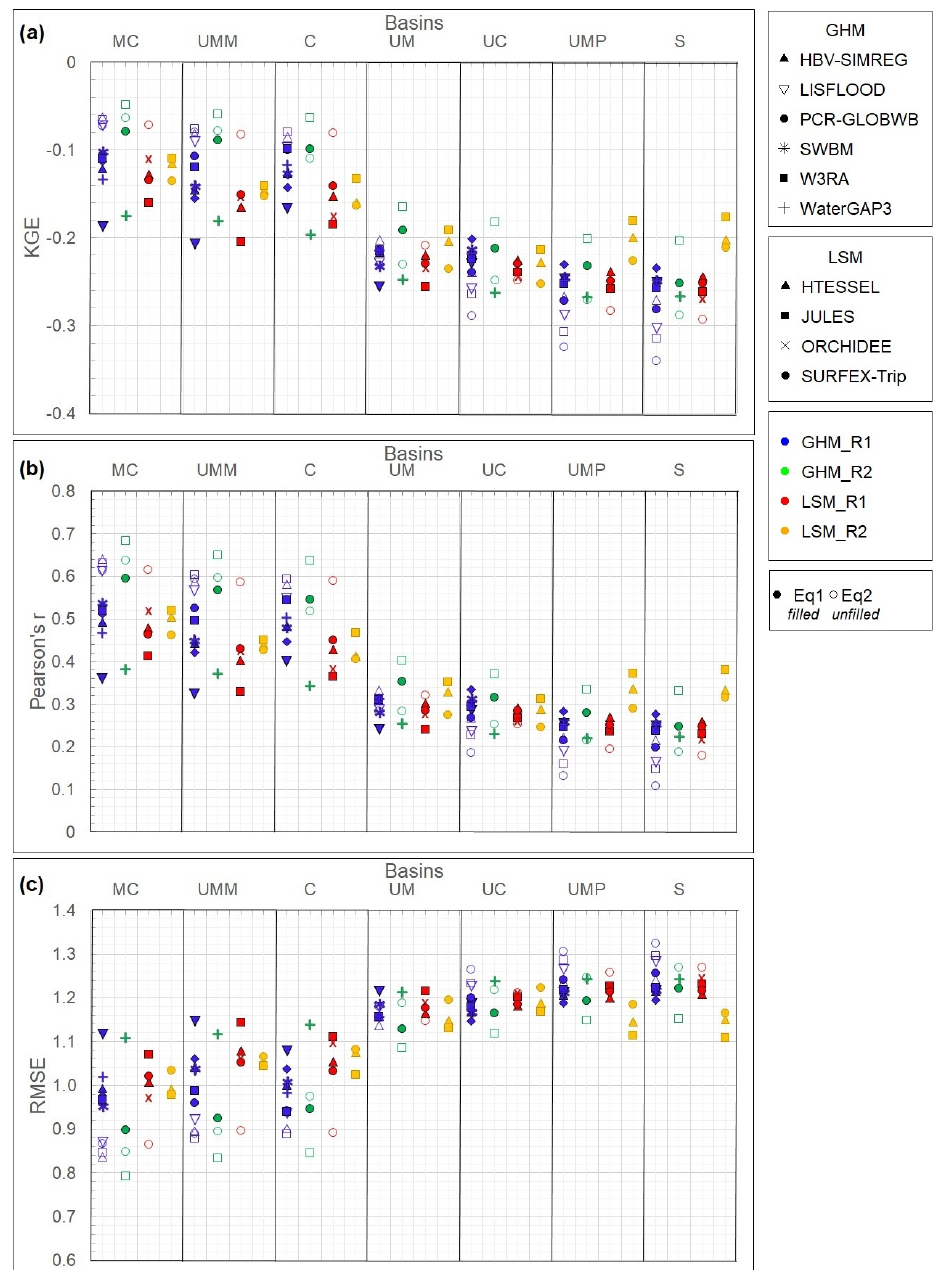
Figure 4. Performance statistics between GRACE and the GHM (blue and green points for WRR1 and WRR2, respectively) and LSM (red and yellow points for WRR1 and WRR2, respectively) at different scales in (a) the KGE index, (b) Pearson’s r , and (c) the RMSE. The basins are ordered by size (largest to the left), and the data are standardised and